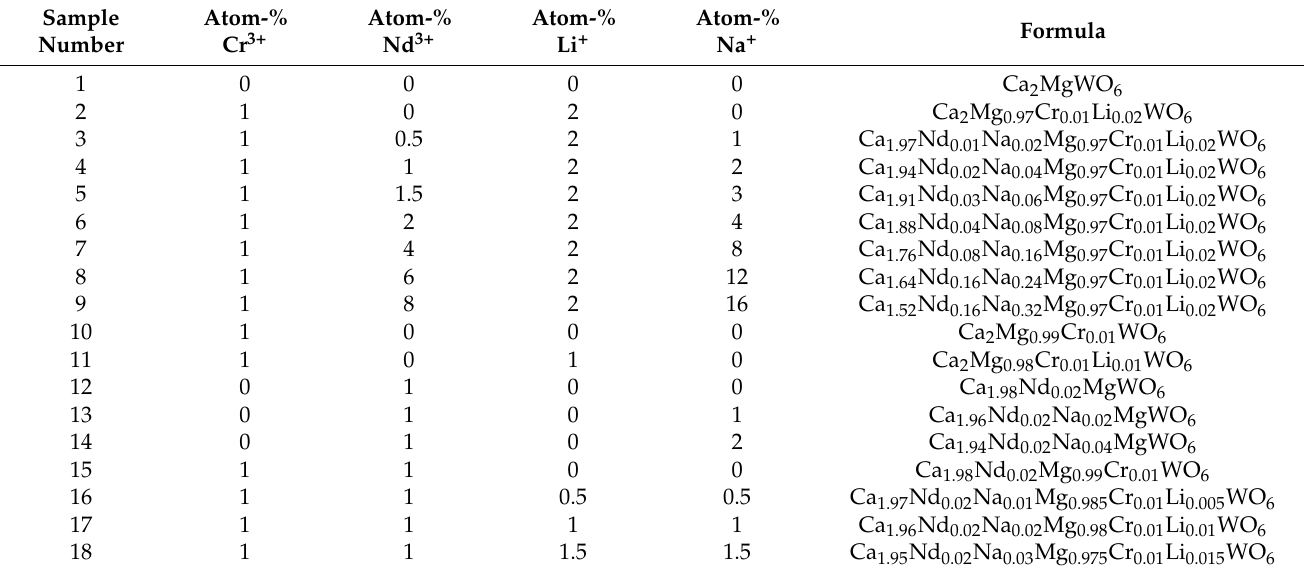
Table 1. Stoichiometric details of prepared